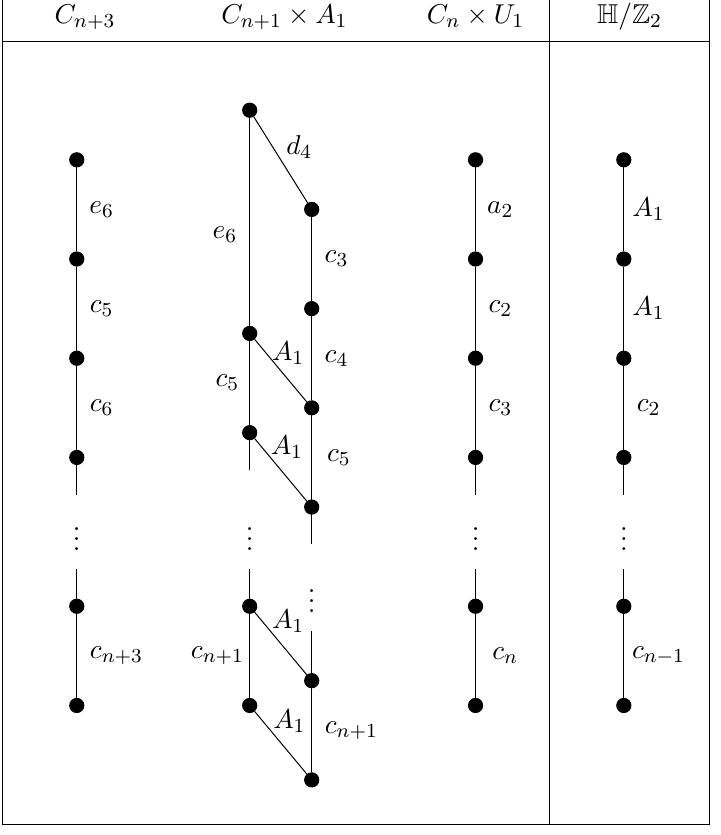
Table 14 . Hasse diagrams for the (cid:12)rst three families of quivers in table 11, and for the generalised H = Z 2 family of quivers in table